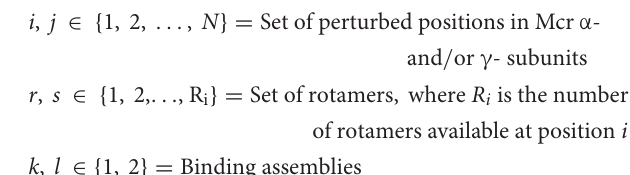
FIGURE 6 | Alternate positions of F463 α and F464 α nearby the coenzyme M binding site for top variants in CS2. The CoM moiety and residues that form its binding pocket within Mcr are shown as balls and sticks, while other key residues are shown as thin sticks. All atoms are colored by atom type (H, white; N, blue; O, red; S, yellow), while carbon atoms are colored orange for WT M. acetivorans Mcr, green for the top variant of CS2, and black for HS-CoB, · CH3, S-CoM, and cofactor F 430 . The conformations of F463 α and F464 α are largely invariant within the top CS2 variants so only the top variant is presented